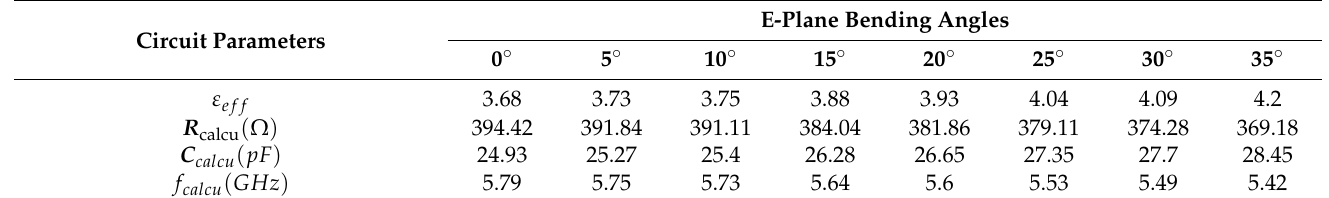
Table 1. Equivalent circuit lumped element parameters with different E-plane bending